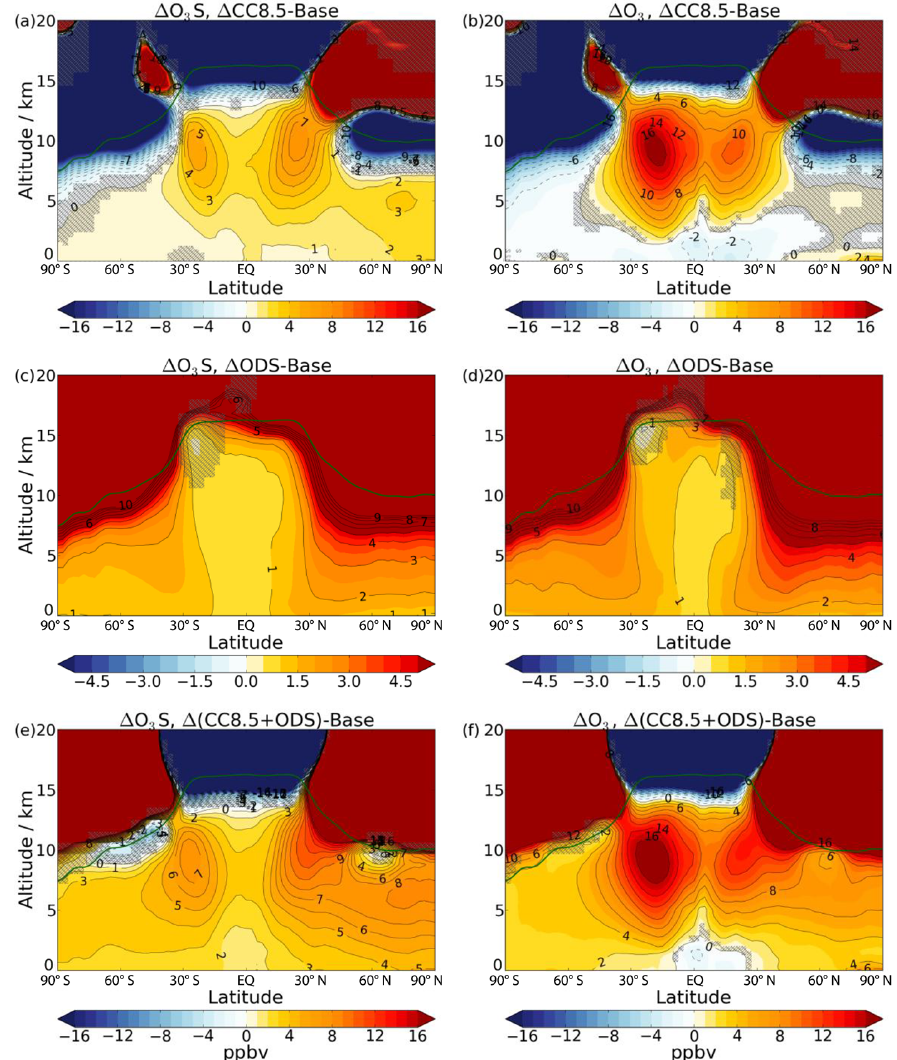
Figure 8. Changes in annual and zonal mean O 3 S (first column) and ozone (second column) mixing ratios (ppbv) from Base to a selection of experiments, (cid:49) CC8.5, (cid:49) ODS and (cid:49) (CC8.5 + ODS). The solid green line indicates the thermal tropopause of the Base run. Strong reductions in O 3 S and ozone occur near the tropopause under climate change because of a lifting of the tropopause, which introduces tropospheric (ozone-poor) air into this